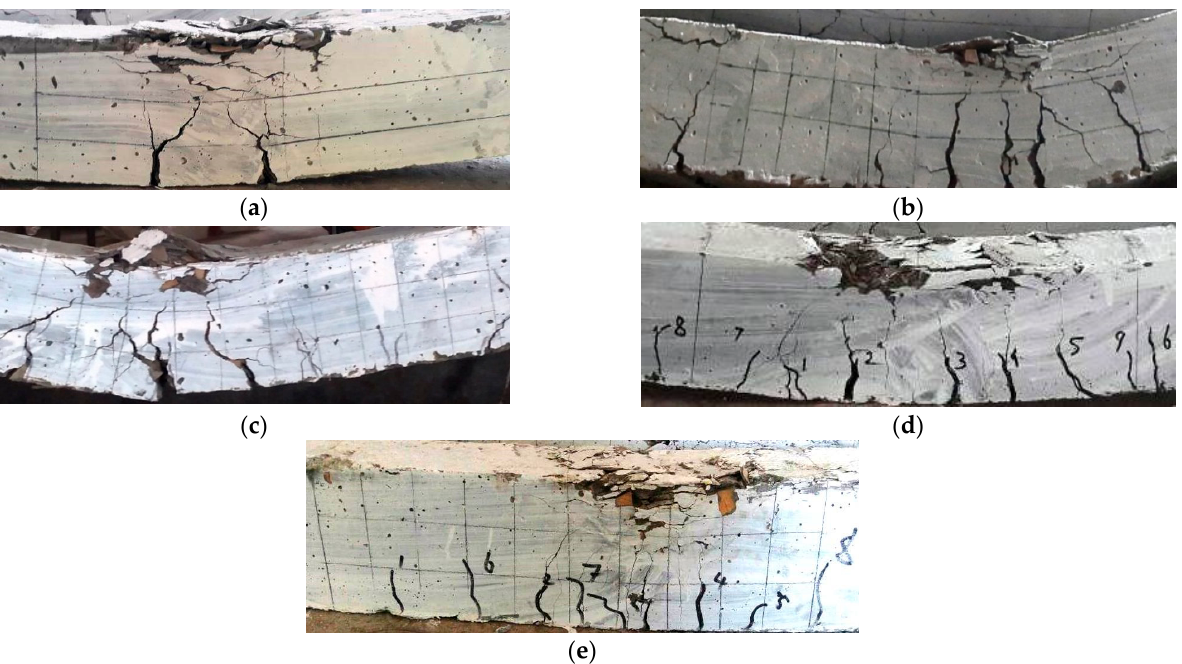
Figure 8. The modes of failure of the CS beams: ( a ) CS, ( b ) CSF25, ( c ) CSF 50, ( d ) CSF 75, and ( e ) CSF100. Annotations: The numbers 1–9 indicate the cracks appearing on the concrete surface in sequence.